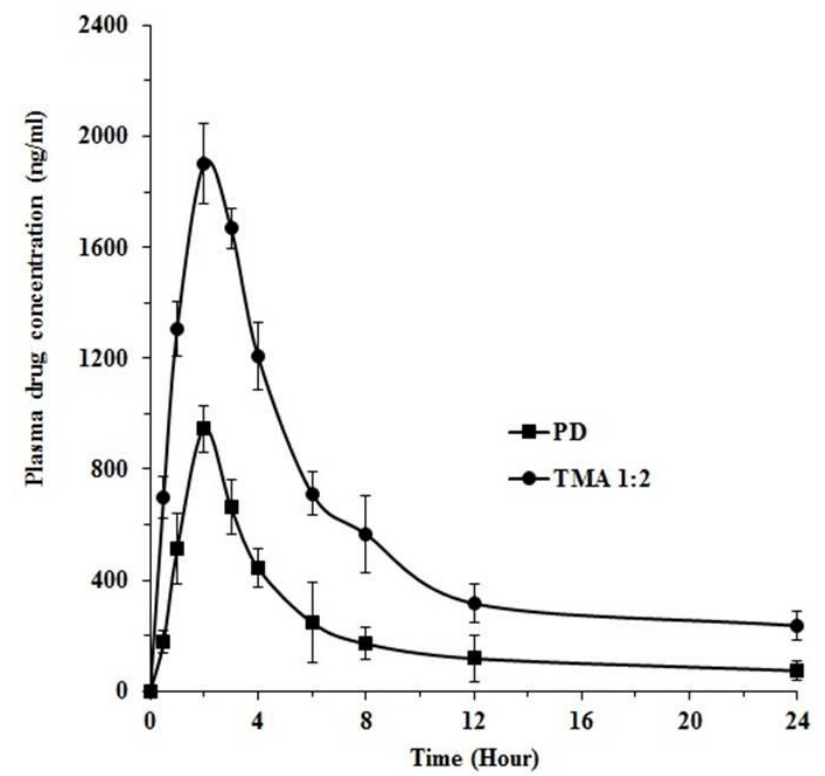
Figure 19. Plasma concentration profile of telmisartan (PD) and optimized telmisartan-maleic acid cocrystals (TMA 1:2 ).